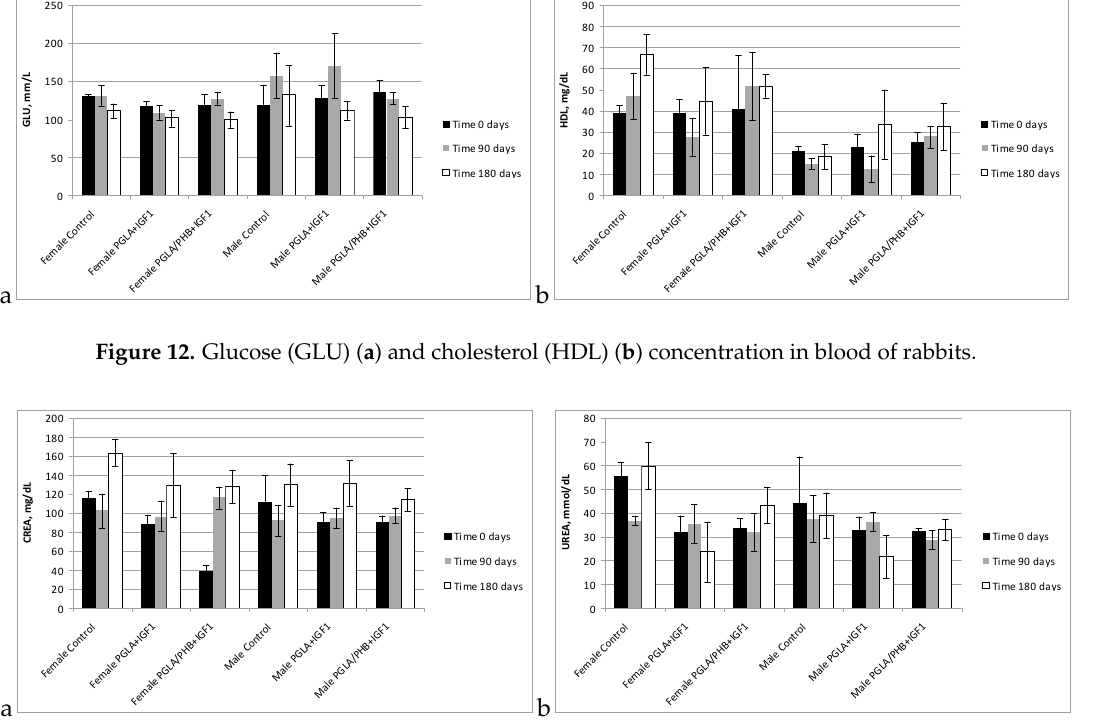
Figure 13. Creatinine (CREA) ( a ) and urea (Urea) ( b ) concentration in blood of rabbits.